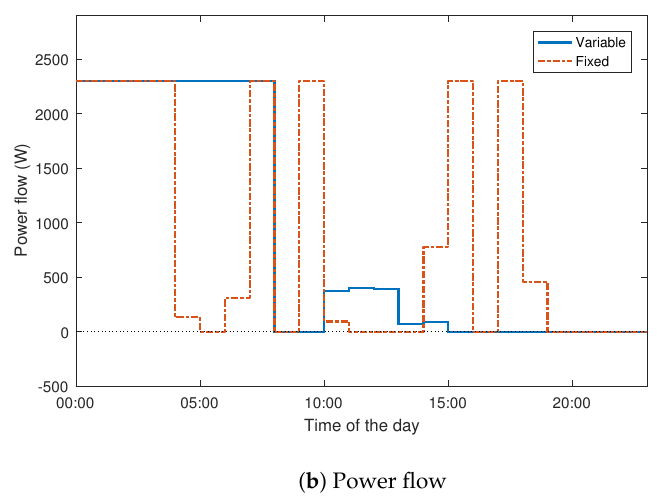
Figure 6. Charge schedule with fixed and variable tariffs.